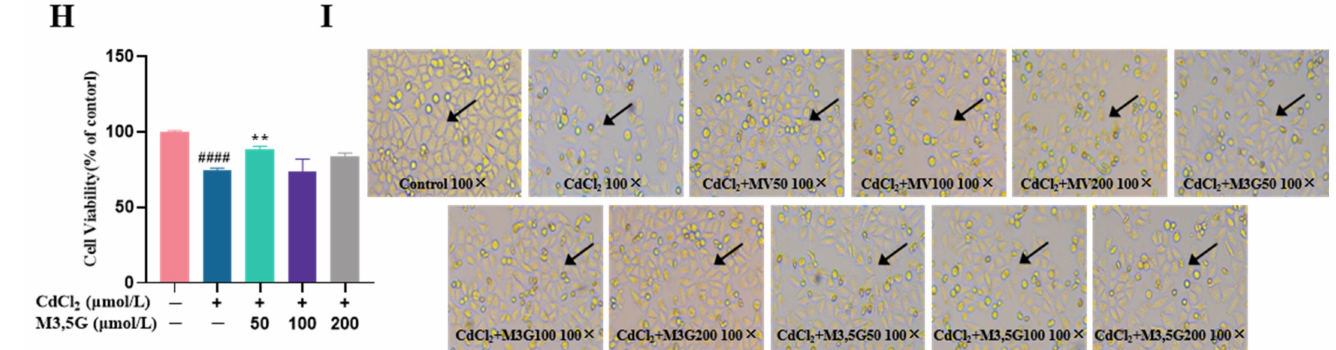
Figure 1. M3G increases CdCl 2 exposure to KGN cell viability. ( A ) The structure of MV, M3G, and M3,5G. Cell viability of KGN cells incubated for 24 h with different compounds: ( B ) treated with CdCl 2 (1.25–40 µ mol/L); ( C ) treated with MV (50–200 µ mol/L); ( D ) treated with M3G (50–200 µ mol/L); ( E ) treated with M3,5G (50–200 µ mol/L); ( F ) treated with 10 µ mol/L CdCl 2 and MV (50–200 µ mol/L); ( G ) treated with 10 µ mol/L CdCl 2 and M3G (50–200 µ mol/L); ( H ) treated with 10 µ mol/L CdCl 2 and M3,5G (50–200 µ mol/L); and ( I ) cell morphology of KGN cells treated for 24 h with 10 µ mol/L CdCl 2 and 50–200 µ mol/L MV, M3G, and M3,5G. Mean ± SD, n = 3. ### p < 0.001, #### p < 0.0001, vs. control; ** p < 0.01, **** p < 0.0001, vs. CdCl 2 -treated group. ns, no